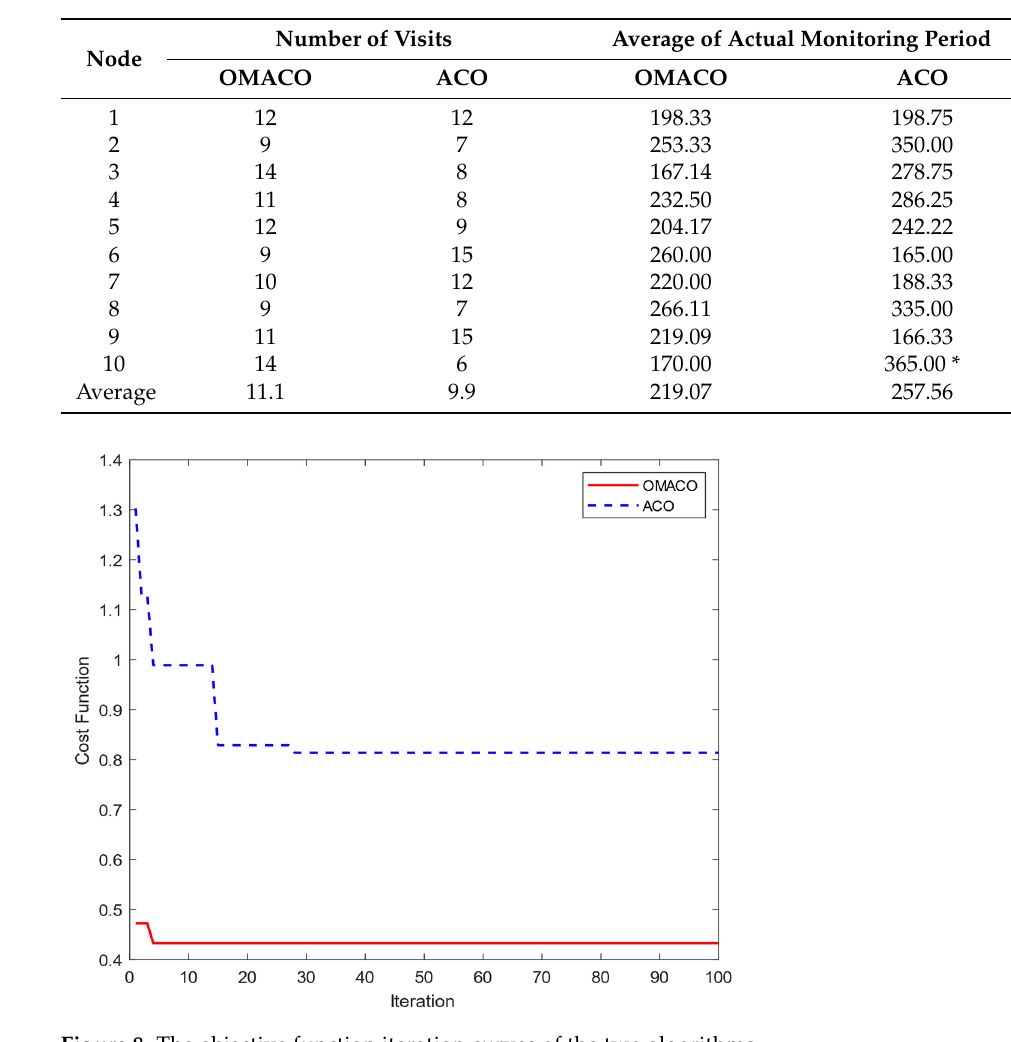
Table 3. Monitoring results comparison between OMACO and ACO.